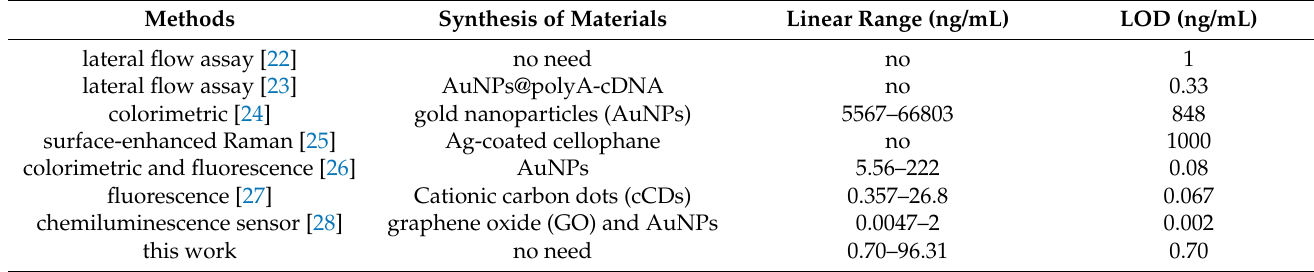
Table 3. Comparison of some published results for ACE detection with this